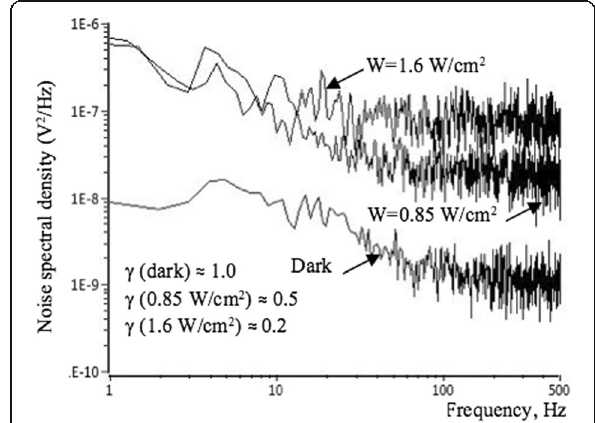
Fig. 7 Noise spectra of NW FET, measured at optical excitation. Spectral dependence of LF noise, measured for NW FET sample with l = 10 μ m under illuminations: 0.85 W/cm 2 , 1.6 W/cm 2 , and in the dark; V BG = − 1 V, T = 300